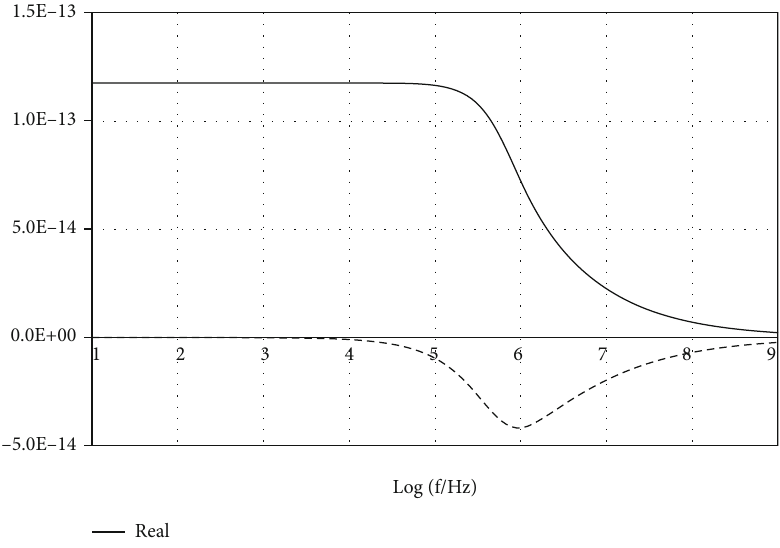
f ), for water-saturated D ’ Euville limestone under di ff erential pressure of Figure 9: S-wave permeability ( κ s ) as a function of frequency ( 3MPa, in which shear modulus G = 12 GPa